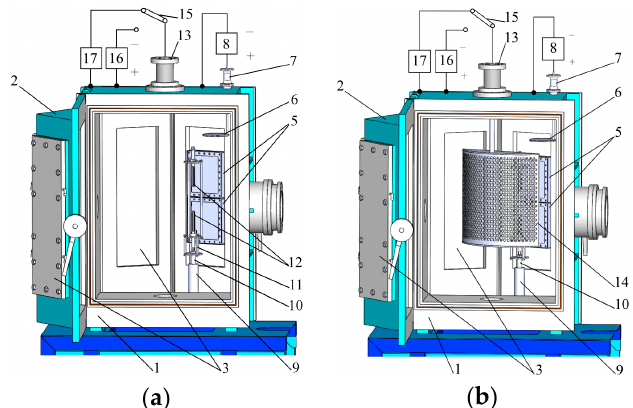
Figure 1. A three-dimensional model of the process vacuum chamber: ( a ) a view with an open door; ( b ) a view with an accelerating grid.